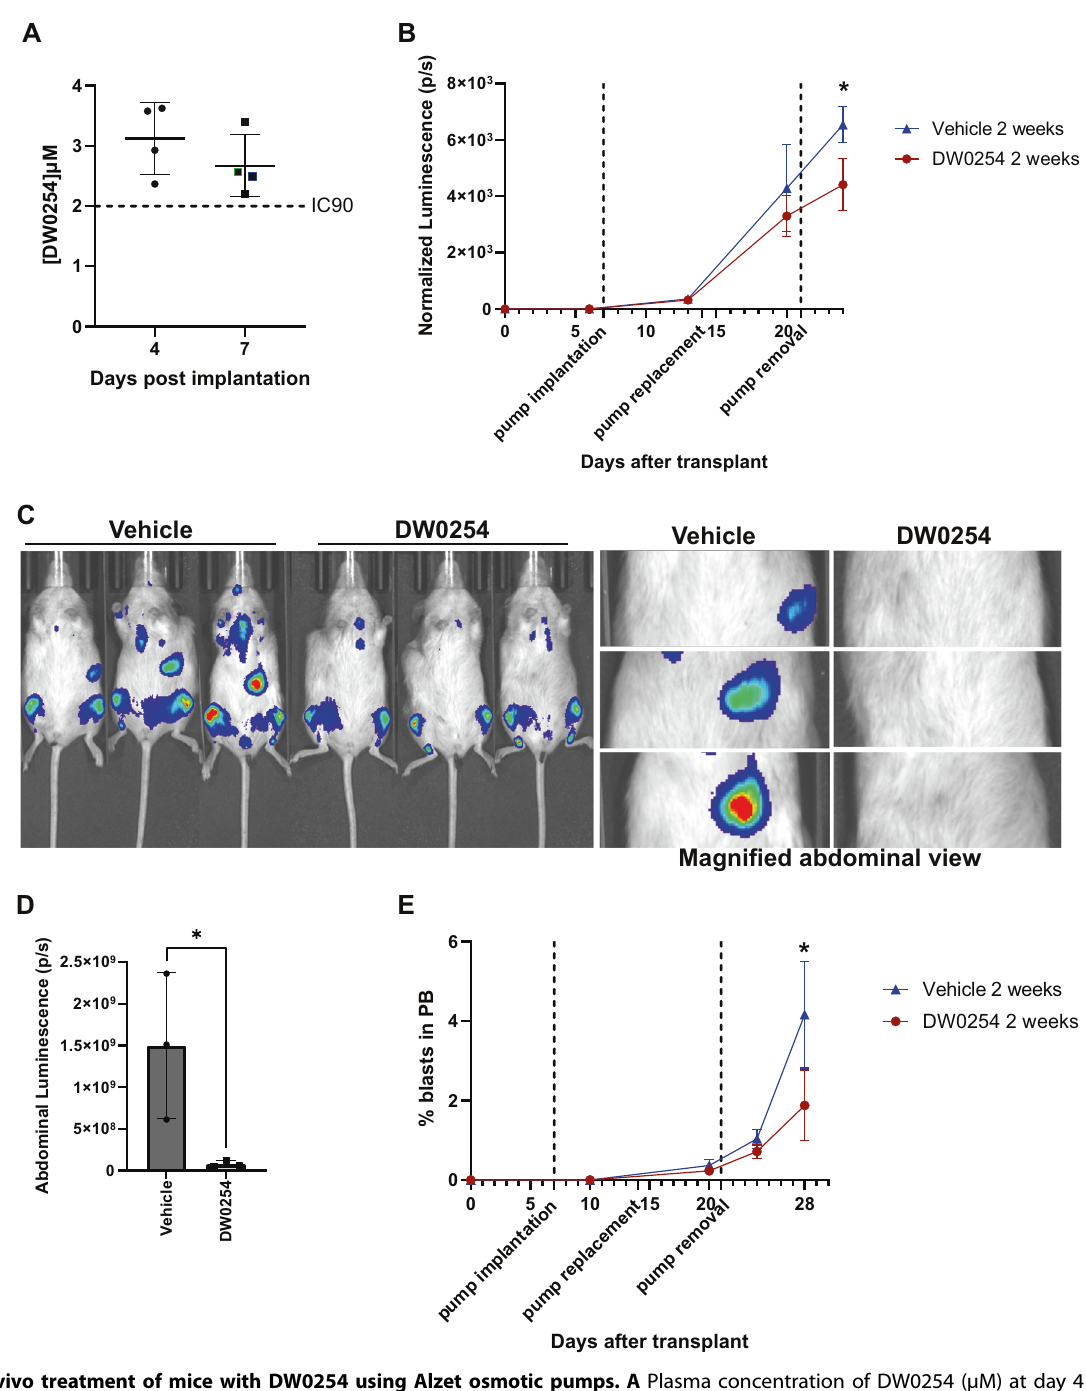
Fig. 7 In vivo treatment of mice with DW0254 using Alzet osmotic pumps. A Plasma concentration of DW0254 (µM) at day 4 and 7 post subcutaneous implantation of Alzet osmotic pumps 2001 containing a 500 mg/ml solution of DW0254 in water with 50% DMSO and 15% Ethanol with a 7-days pumping rate of 1 µl/h. Individual values as well as mean ± SD of four animals are shown. B Changes in luminescent signal in units of photons/s (p/s), after luciferase expressing P12-ICHIKAWA xenograft for mice implanted with DW0254 or vehicle control pumps at day 7 and replaced at day 14 post-transplant. Photon fl ux signal after pump implantation was normalized over signal before implantation for each mouse. C Bioluminescent images of day 24 post-transplant (last data point of panel B ) of mice treated with DW0254 or Vehicle control pumps from day 7 to day 21 and magni fi ed abdominal view showing increased spleen signal in control mice. D Bar graph showing quanti fi cation of abdominal bioluminescence depicted in panel ( C ) right. Welch ’ s correction t -test was used for statistical analysis since variances between the groups were signi fi cantly different. E Percentage of blasts in the peripheral blood (PB) of mice treated with DW0254 or Vehicle control pumps for 2 weeks. Data in B , D , and E represent mean ± SD, n = 3 animals for each condition. * p <